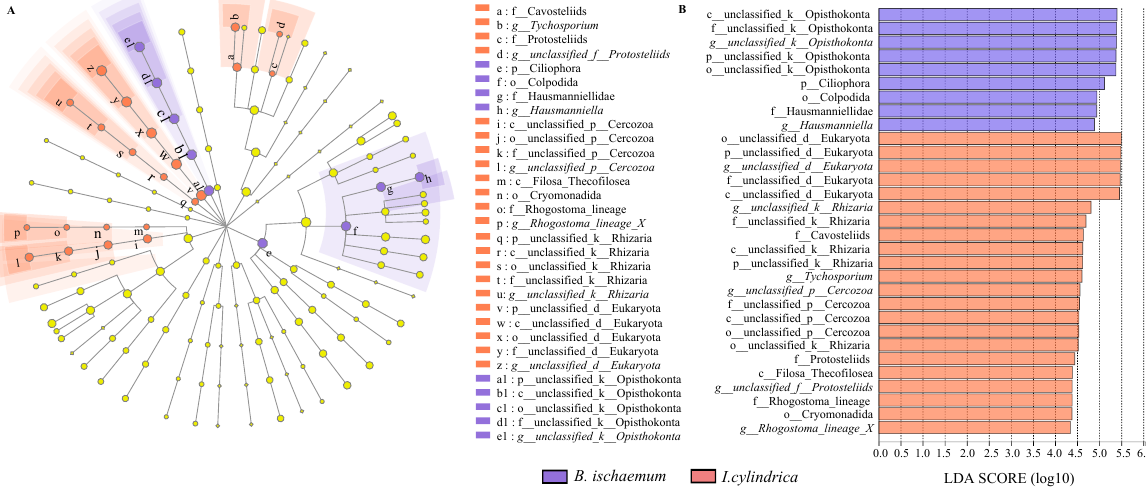
Figure 3. LEfSe analysis of protist communities among the two litter types ( A ): LEfSe analysis of protist communities with LDA scores greater than 2.0. Different color nodes indicate a significant enrichment in corresponding groups, while yellow nodes indicate no significant differences between groups. ( B ): LDA bars represent protist communities among the two litter types with LDA scores greater than